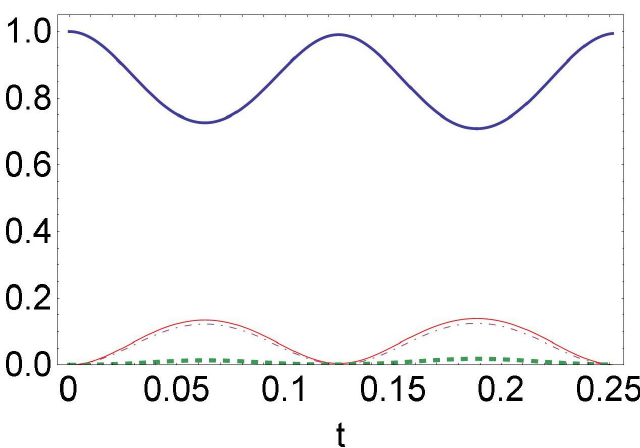
Figure 3. Time evolution of the coefficients a k ( t ) of Equation (16) in the adiabatic case, corresponding to the Hamiltonian given by Equations (29) and (30) with the following parameters: m = 1/75, L 0 = 37, q 1 = 7, q 2 = 7.04, ω = 25 (verifying ( T = 2 π / ω ) < ( τ = L 0 / c ) where c is the light velocity). The initial ( x ,0 ) . The thick solid blue line represents the numerically computed values of state is φ ( x ,0 ) = ψ II n = 2 ( t ) | 2 while the inset shows the corrections to the adiabatic approximation stemming from exact numerical | a 2 computations: | a k ( t ) | 2 for k = 1,3,4 are represented by the blue dot-dashed, solid red, and dashed green curves, respectively. We use atomic units (¯ h = m e = 1, c = 1/ α (cid:39) 137), where α is the fine structure constant and the unit of time corresponds to 2.42 × 10 − 17 s.